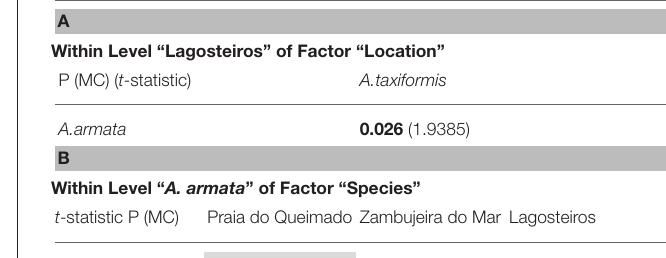
TABLE 3 | (A) Pairwise PERMANOVA comparisons for species within Lagosteiros using Monte Carlo 999 simulations (MC). (B) Pairwise PERMANOVA comparisons for Locations within each Asparagopsis species using Monte Carlo 999 simulations (MC).